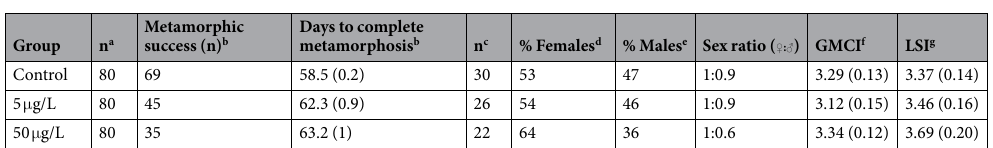
Table 2. Summary table of evaluated endpoints. a Initial sample size. b Data are modified from Bernabò et al . 26 . c Number of one week recent metamorphs of H . intermedia used for histological observations and phenotypic sexed. d Percentage of phenotypic females. e Percentage of phenotypic males. f GMCI = gonad-mesonephros complex index. g LSI = liver somatic index. Values are reported as means ( ± standard